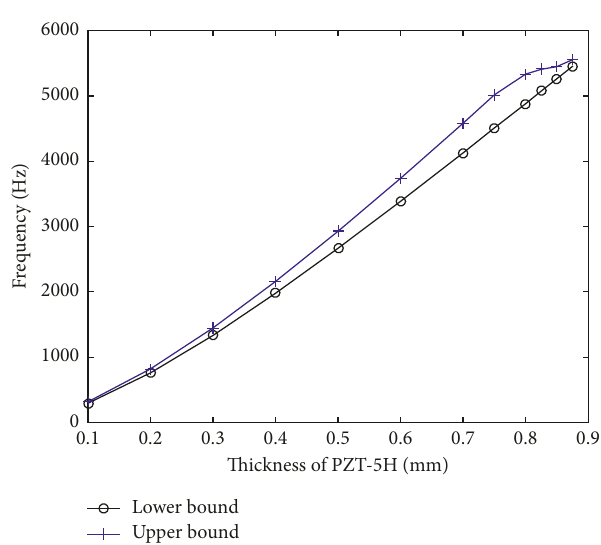
Figure 13: Lower and upper bounds vs. thickness of